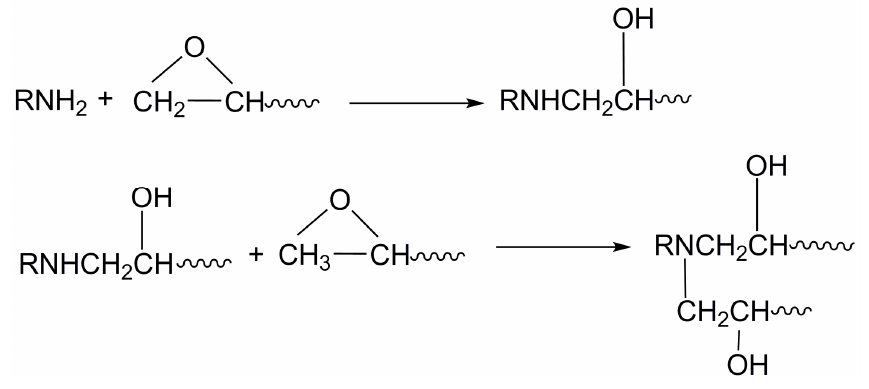
Figure 11. Cure reaction mechanism of amine and epoxide [29].